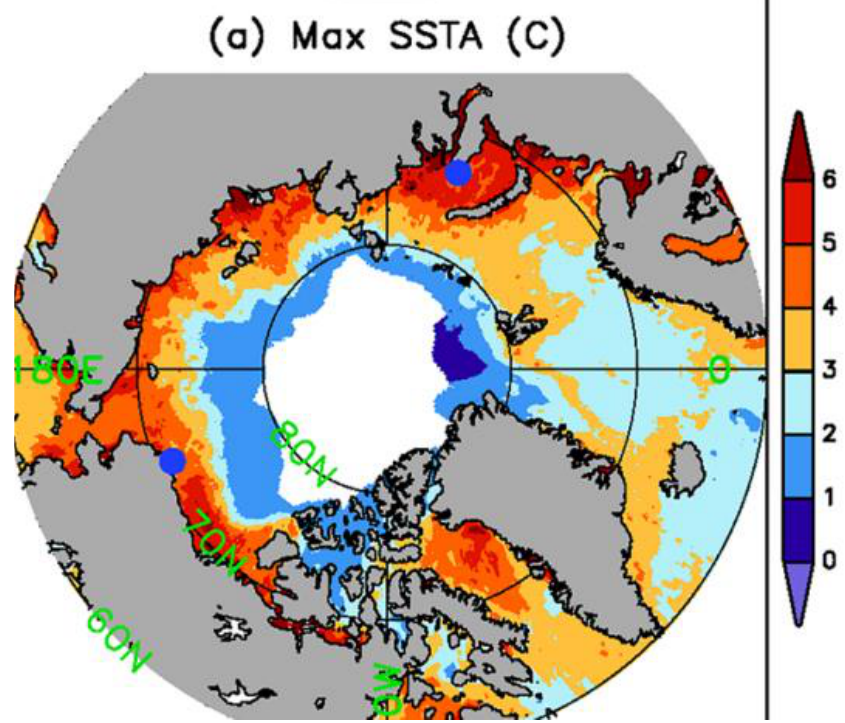
Figure 3. Maximum (1980 – 2020) sea surface temperature anomaly (SSTA in °C), derived using the 95th percentile threshold [8].